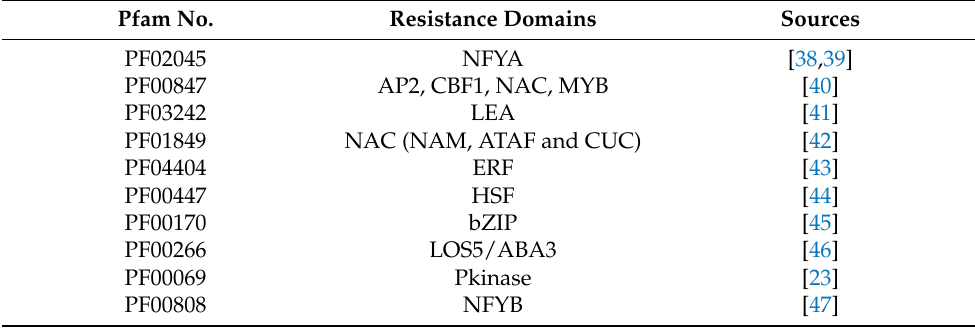
Table 3. Information of 16 resistance